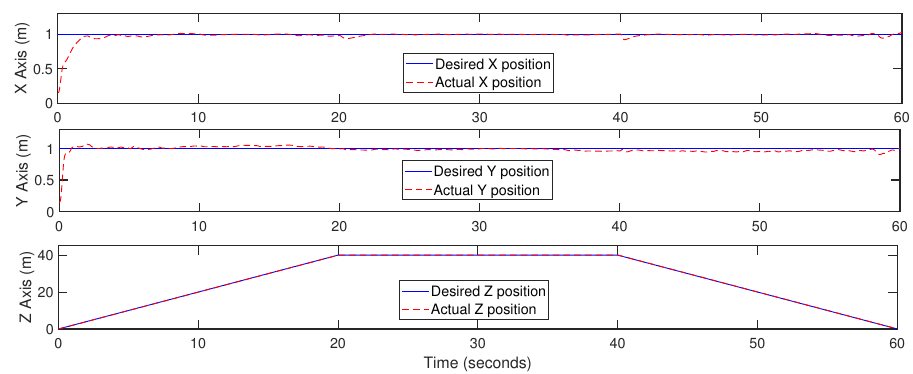
Figure 19. Position tracking with Von Karman wind turbulence model. Similarly, Figure 20 shows small fluctuations in the attitude